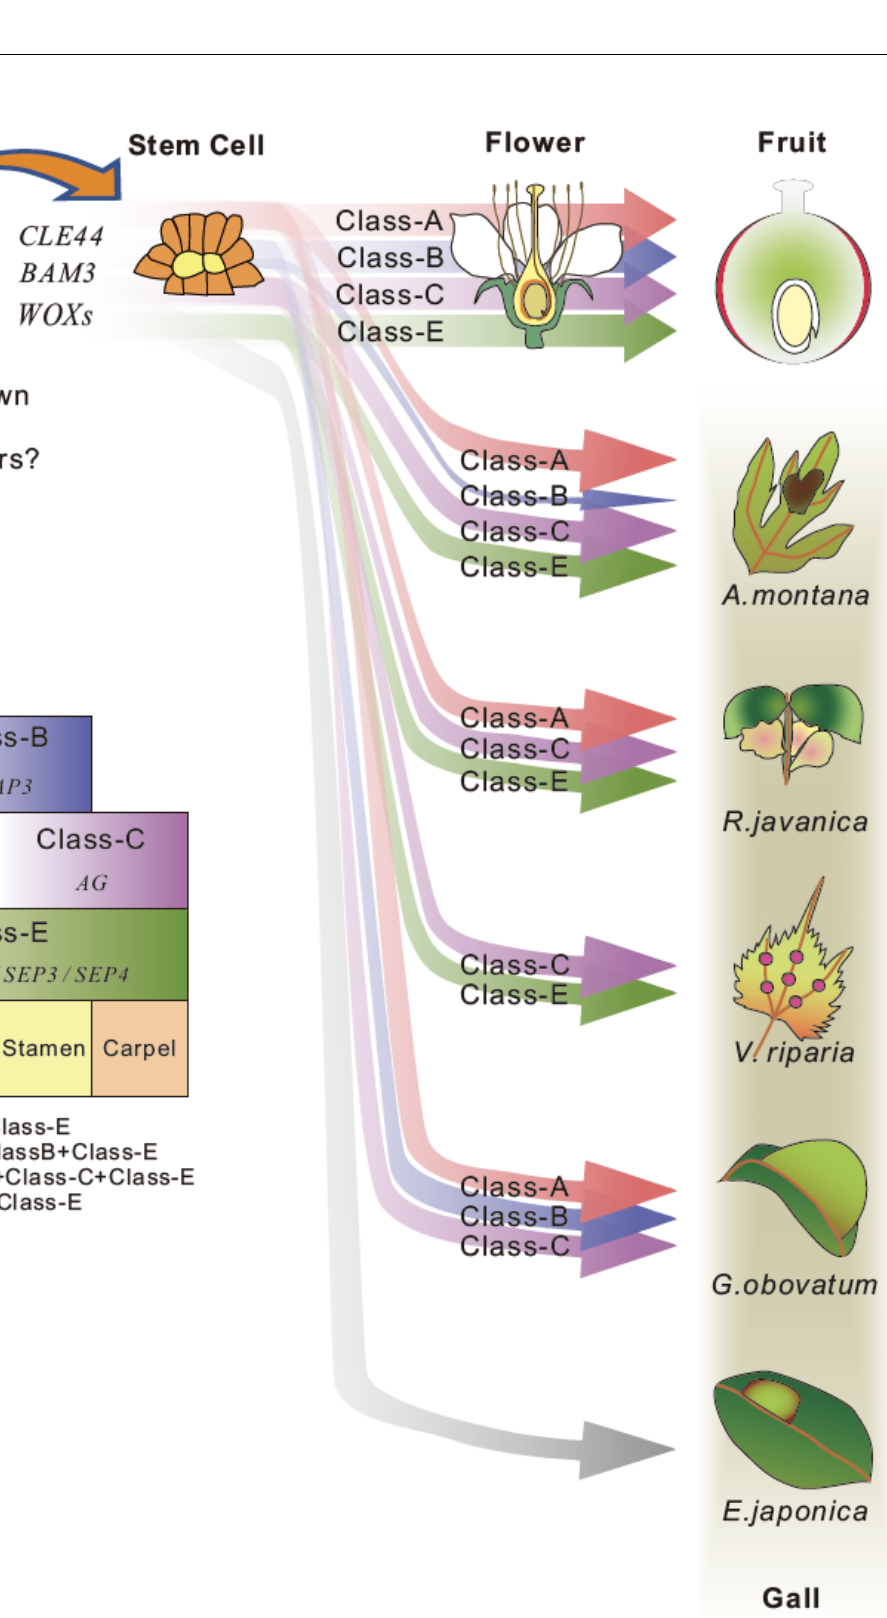
5. Conclusions Herein, we reviewed the molecular aspects of insect gall induction and development. The ancestral lifestyle of gall-inducing insects varies among taxa, from ectophagous herbivores (foliage feeders, sap-feeders, and pollen-feeders), plant-mining herbivores (leaf-miners and stem-borers), and fungus-feeders to parasitoids. Reports on the origin of leaf miners are scarce. Regarding the adaptive significance of galls for insects, the nutritive